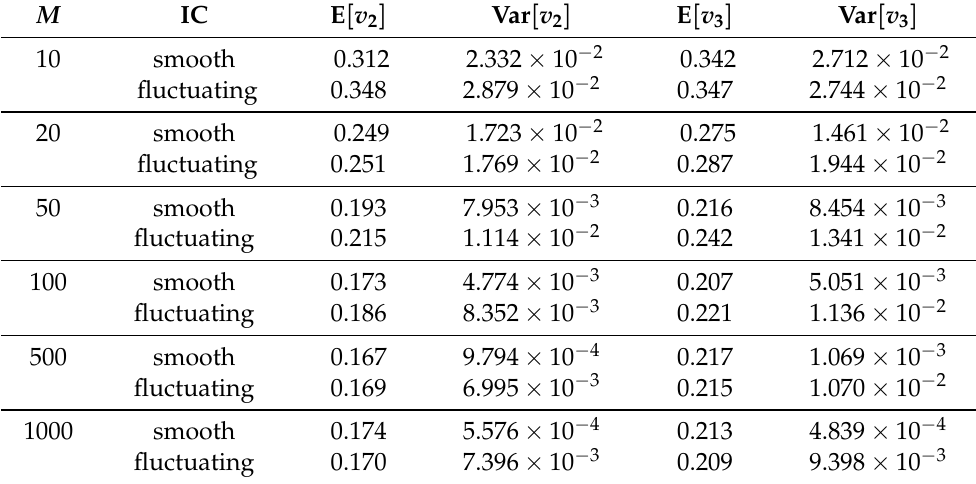
Table 2. The same as Table 1, but the calculations are carried out for N =